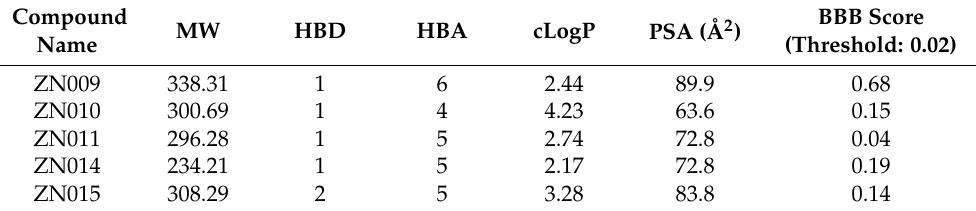
Table 1. Bioavailability and BBB permeation prediction of ZN